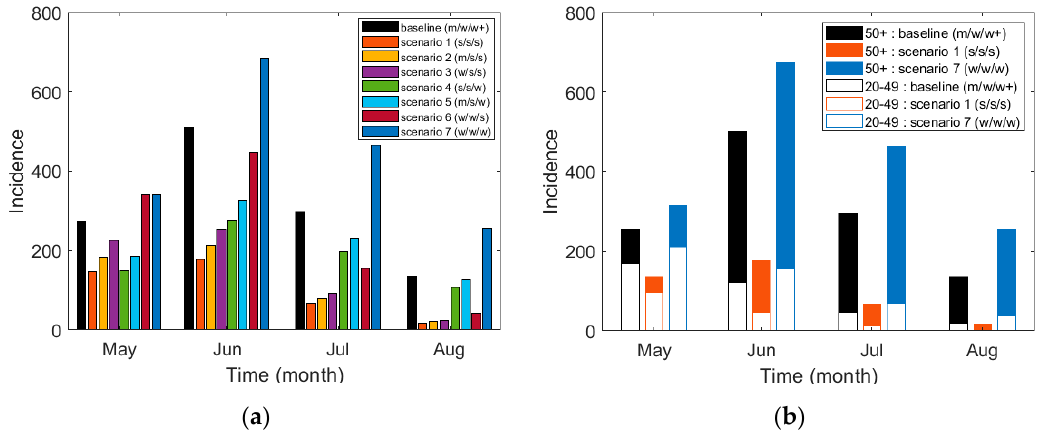
Figure 7. Cumulative incidence based on scenarios: ( a ) the monthly incidence for the total age group and ( b ) the monthly incidence of the two age groups of 20–49 and 50 and older (50+) for the baseline (scenarios 1 and 7).